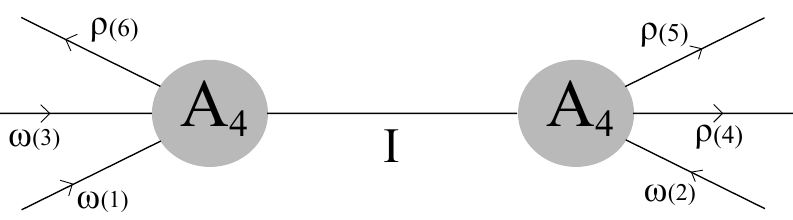
Figure 1 . Graphic representation of a generic contact contribution to the six-point amplitude. Here 1 , 2 , 3 label incoming particles and ω their S 3 permutation, whereas 4 , 5 , 6 label outgoing particles and ρ their S 3